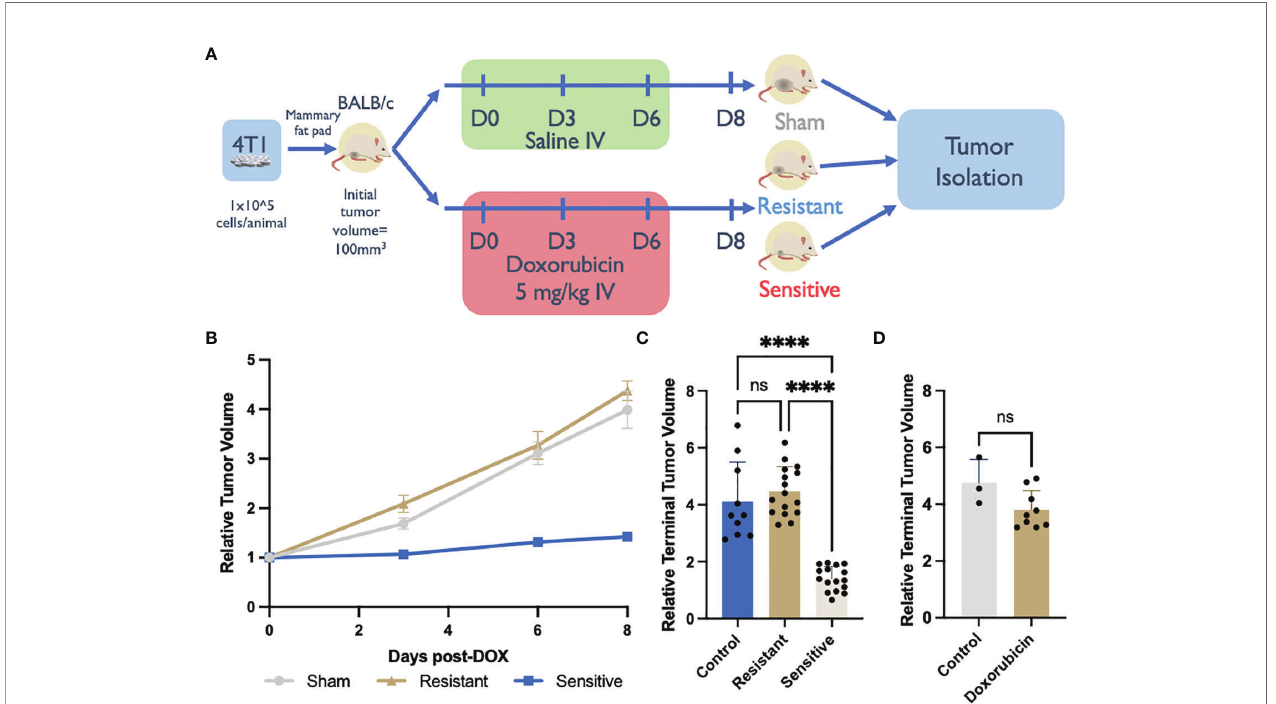
FIGURE 1 | Syngeneic 4T1 tumors differentially respond to doxorubicin (DOX) treatment. (A) DOX treated BALB/c 4T1 mammary fat pad tumor experimental design. (B) Syngeneic tumor growth rates of tumors in response to DOX. Relative tumor volume was normalized to initial volume and calculated from caliper measurements throughout the experiment. (C) Relative terminal tumor volume at Day 8 post DOX initiation from saline-treated controls or DOX treated tumors in immunocompetent BALB/c mice binned into resistant or sensitive populations (n=10-16). (D) Relative terminal tumor volume at Day 8 post DOX initiation from saline- treated controls or DOX treated tumors in immunode fi cient NSG mice (n=3-9). ns: non-signi fi cant p > 0.05, **** p <